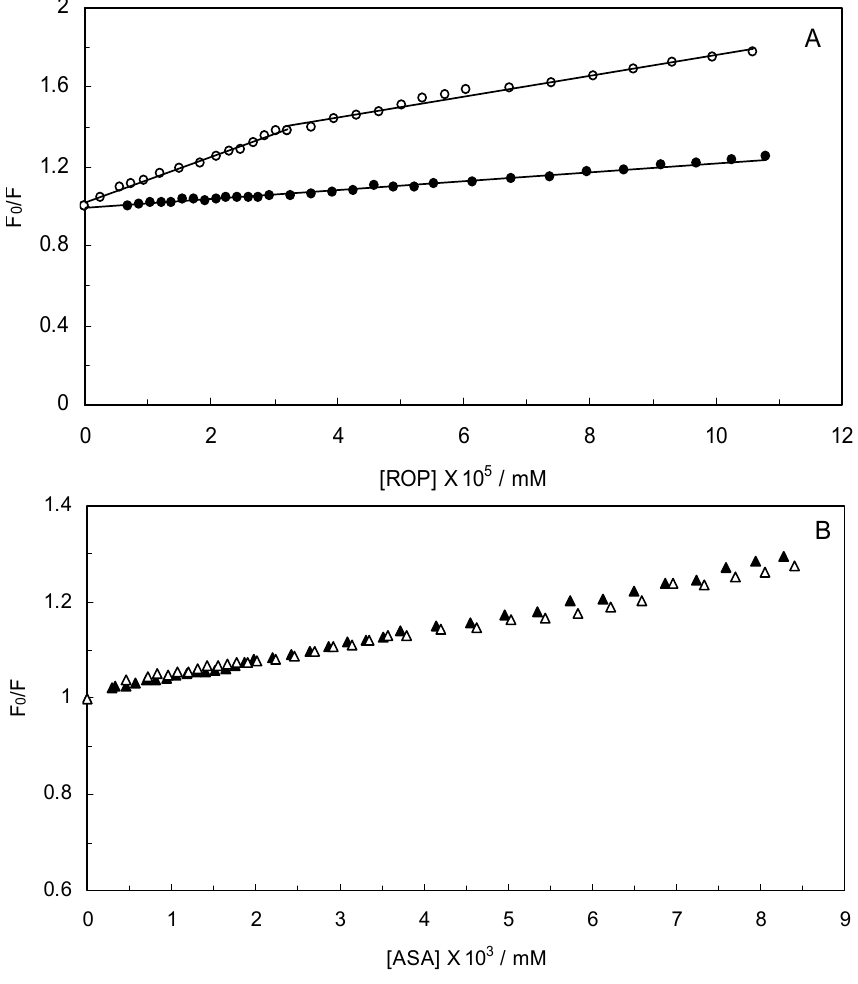
Figure 2. ( A ) Stern-Volmer plots for the binding of ROP to hTf in the absence and presence of ASA. [ASA] = 4.62 × 10 − 3 mM, binary system ( ○ ); ternary system ( ● ); ( B ) Stern-Volmer curves for the binding of ASA to hTf in the absence and presence of ROP. [ROP] = 1.33 × 10 − 5 mM, binary system ( ∆ ); ternary system ( ▲